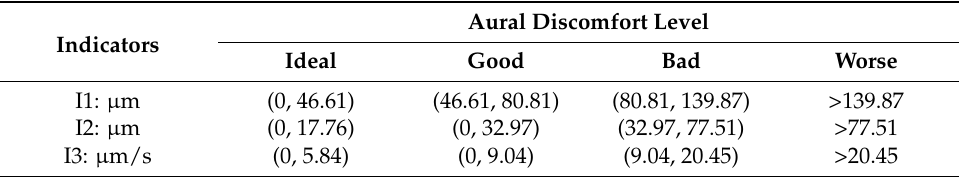
Table 3. Interval of each discomfort level.